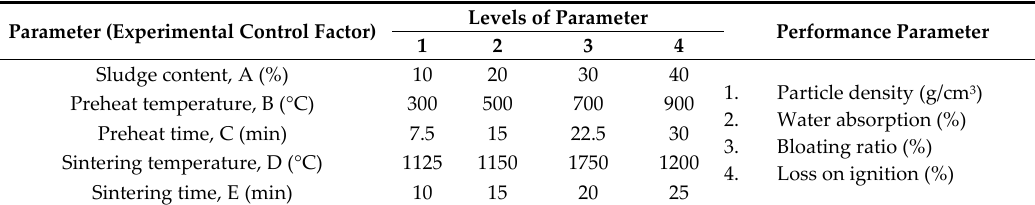
Table 1. Process parameters and design levels.